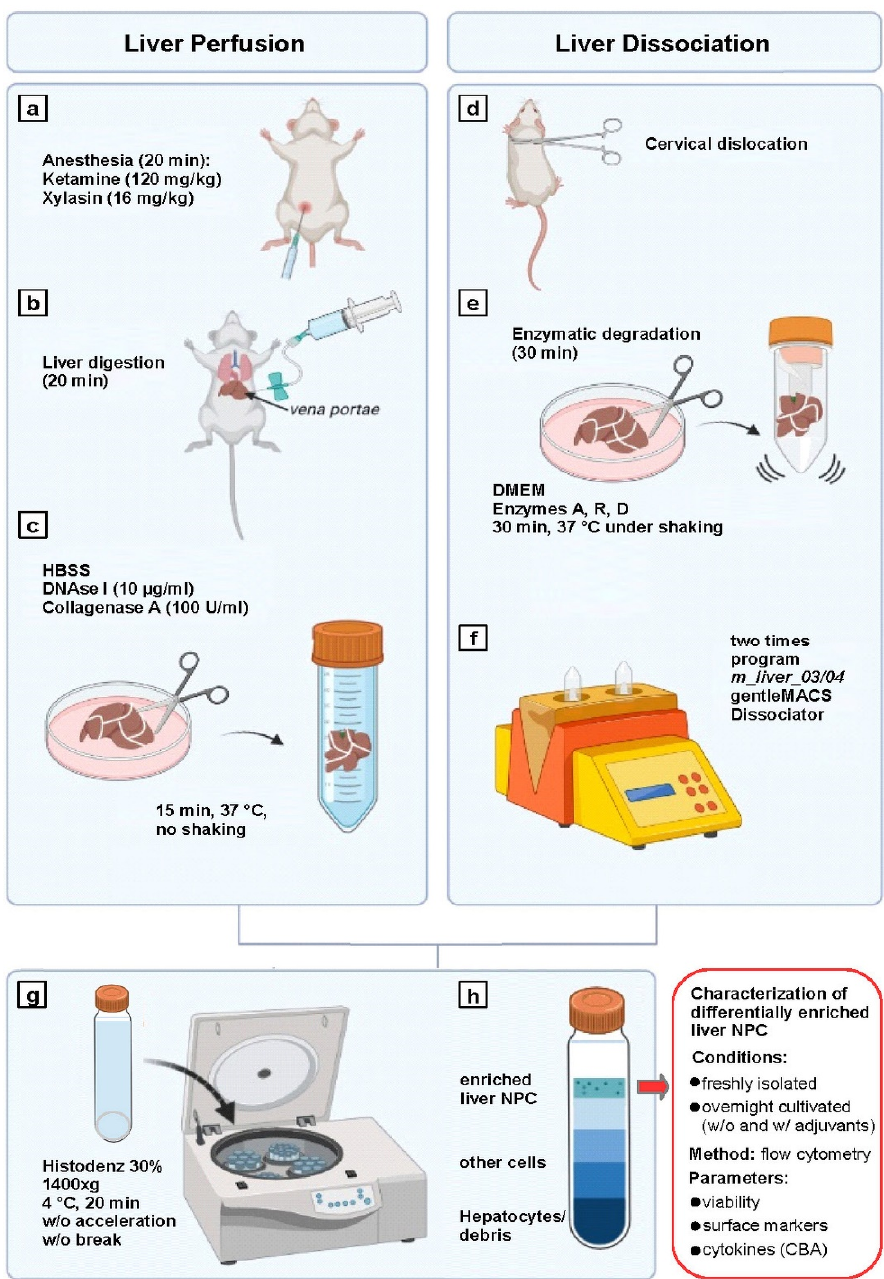
Figure 1. Schematic overview of liver non-parenchymal cell (NPC) enrichment by liver perfusion (LP) and liver dissociation (LD) and subsequent experimental readout. Left panel: LP mice were ( a ) anesthetized with ketamine/Xylazine, ( b ) the vena portae was cannulated and collagenase A/DNase I-containing PBS was infused for in situ tissue digestion. ( c ) The liver was retrieved, cut into pieces and further digested with collagenase A/DNase I. Liver tissue pieces were mashed to obtain a single cell suspension (not shown). Right panel: LD mice were ( d ) killed by cervical dislocation, and ( e ) the retrieved liver was cut into pieces and digested in an enzyme cocktail of proprietary composition (Miltenyi Biotec), ( f ) followed by mechanical dissociation using a gentleMACS (Miltenyi Biotec). Lower left panel: Liver cell suspensions generated by either method were ( g ) subjected to Histodenz density gradient centrifugation, ( h ) resulting in enrichment of liver NPCs in the interphase that was subjected to subsequent experiments. Lower right panel: differentially enriched liver NPCs were characterized in a freshly isolated state and after overnight incubation w/o and in the presence of adjuvants with regard to viability, surface marker expression, and cytokine contents by flow cytom- etry. (created with BioRender.com; accessed on 1 June2022).